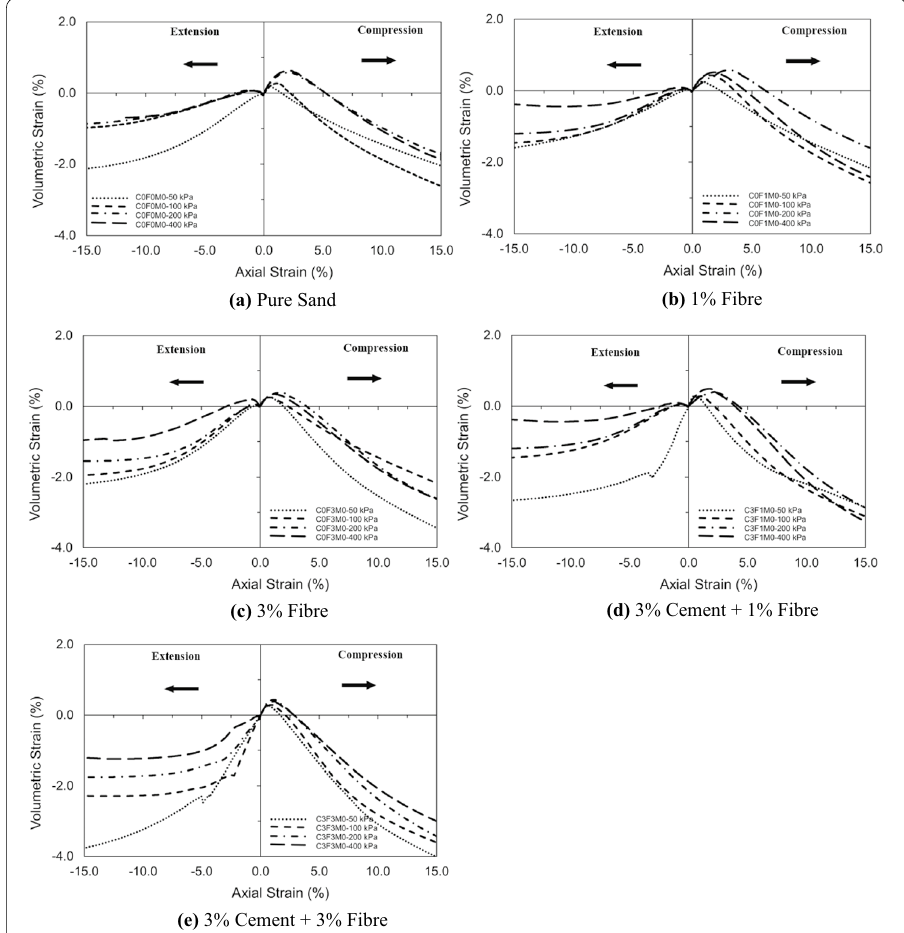
Fig. 6 Volumetric strain ( ǫ v ) vs axial strain ( ǫ a ) curves from CID compression and extension tests for unreinforced, fibre, and fibre reinforced cemented Toyoura sand specimens consolidated to varying mean effective stresses ( p’ ) a Pure sand b 1% fibre c 3% fibre d 3% cement